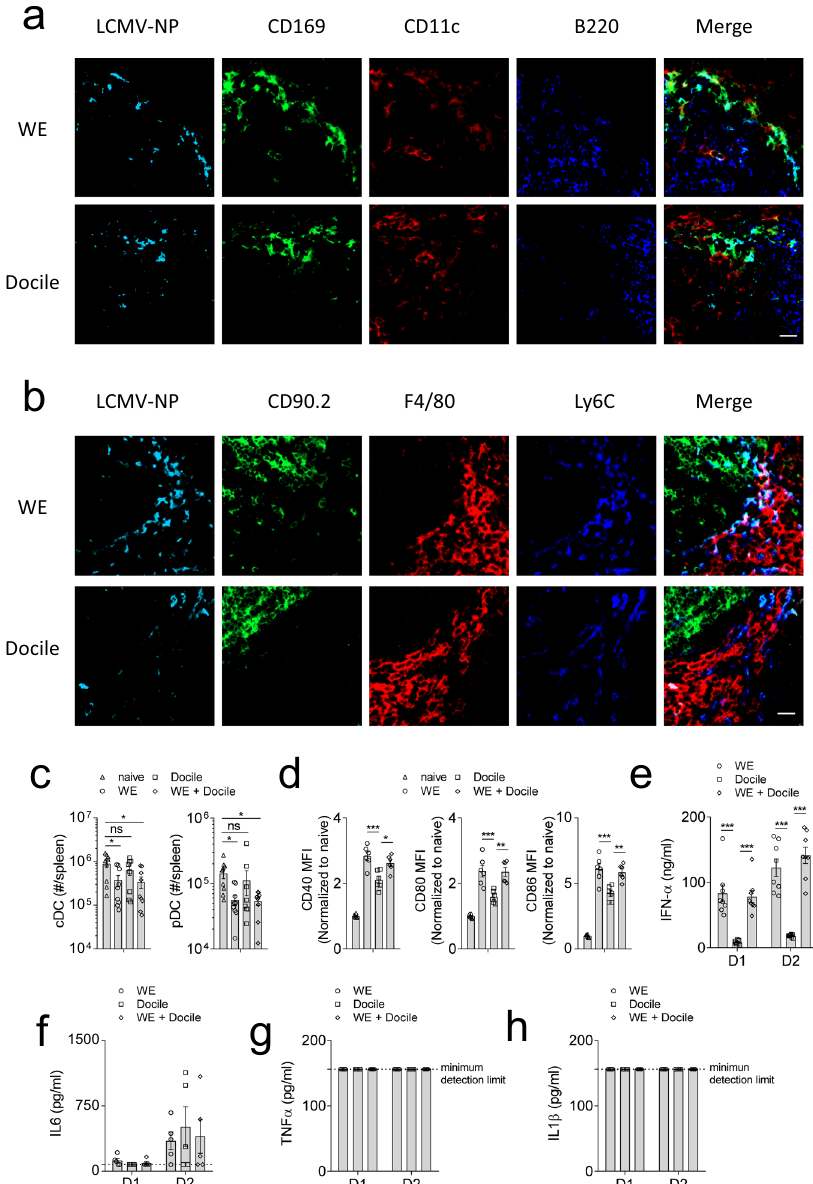
Fig. 2 Co-infection with LCMV-WE reverses the immunosuppressive effects of chronic LCMV-Docile viral infection through enhanced DC activation. a , b C57BL/6 mice were infected with 2 × 10 4 pfu LCMV-WE (WE), and LCMV-Docile (Docile). At day 2 post-infection, spleen tissues were stained for LCMV antigen NP, CD169, CD11c, and B220 ( a ) or CD90.2, F4/80, and Ly6c ( b ) (representative sections are shown ( n = 4) scalebar = 20 µ m). C57BL/6 mice were infected with LCMV-WE (WE), LCMV-Docile (Docile), or WE together with Docile (WE + Docile). c , d At day 2 post-infection, numbers of c splenic cDC (CD11c + MHC-II + ) and pDC (B220 + Siglec-H + ) were determined ( n = 9, gating strategy is shown in Supplementary Fig. 3). d Co- stimulatory molecules CD40, CD80, and CD86 were measured on splenic cDC ( n = 6). e Serum IFN- α concentrations were determined at the indicated time post-infection ( n = 9). f Serum IL-6, g serum TNF- α , h serum IL-1 β concentrations were measured at the indicated timepoints ( n = 5). (Error bars show SEM, * p < 0.05, ** p < 0.01, *** p < 0.001, and ns indicates statistically not signi fi cant between the indicated